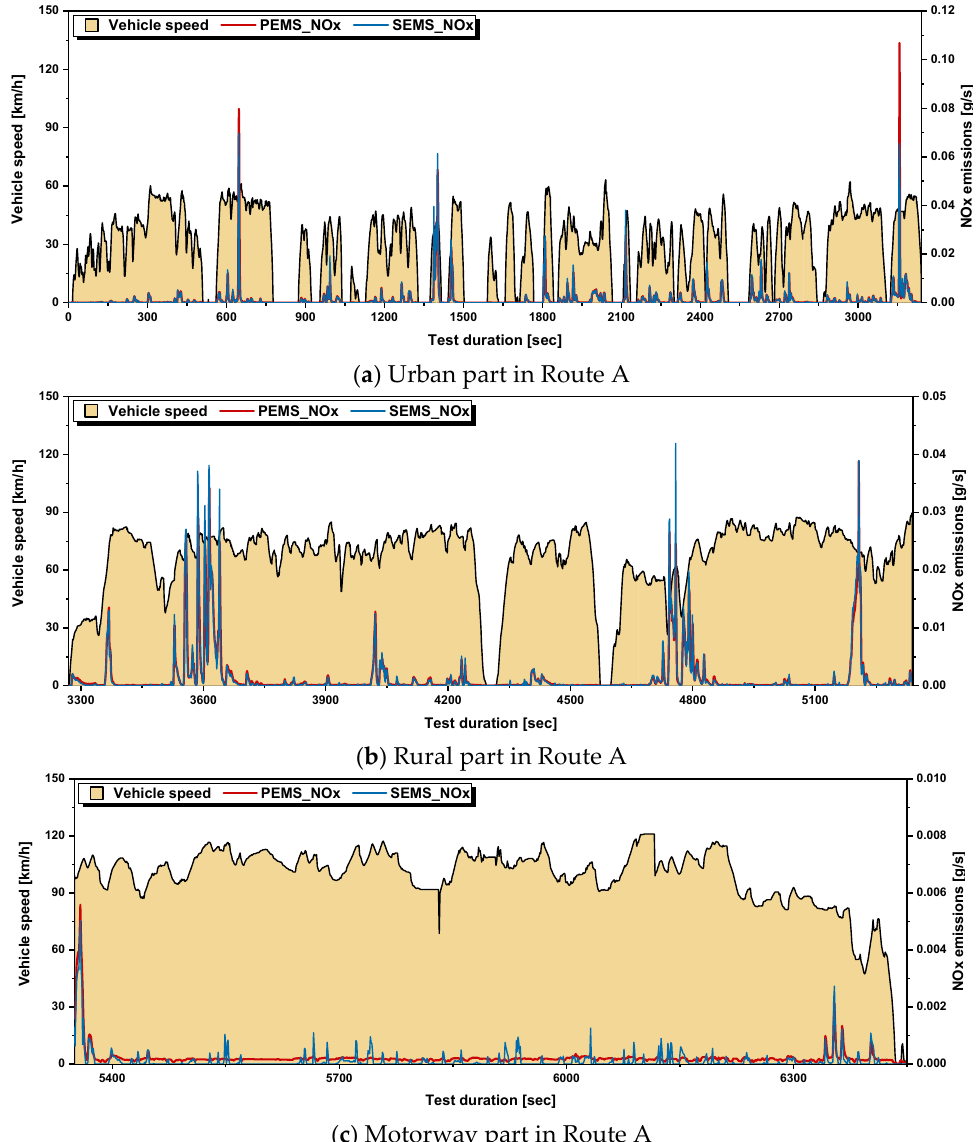
Figure 18. Real-time profiles of NOx emissions measured by the PEMS and SEMS equipment under RDE Route A .